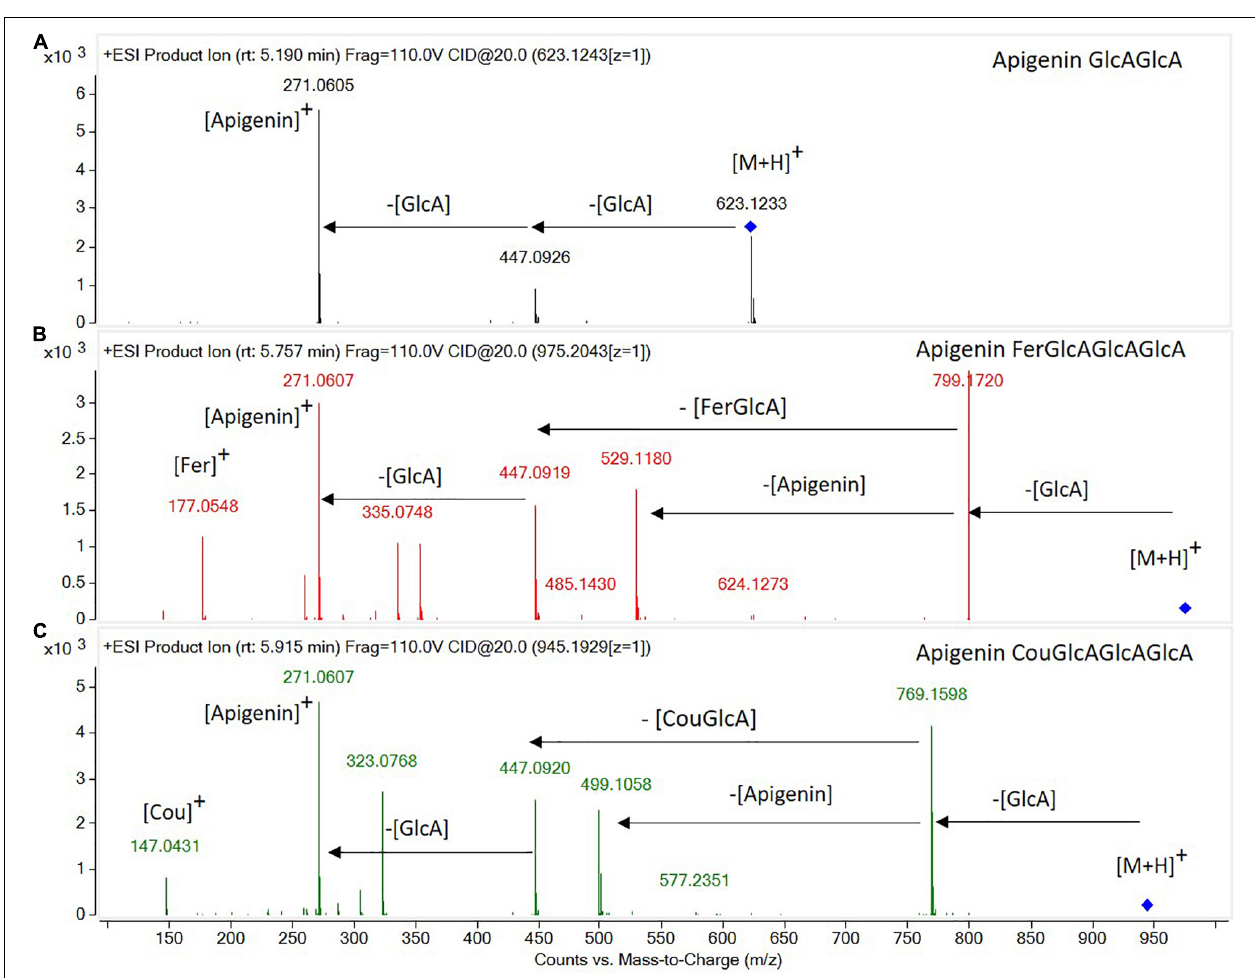
diglucuronide ( 23, 6 ), chrysoeriol feruloyl-triglucuronide ( 13 ) and the three positional isomers of the anthocyanidin peonidin glucoside ( 1, 12, 21